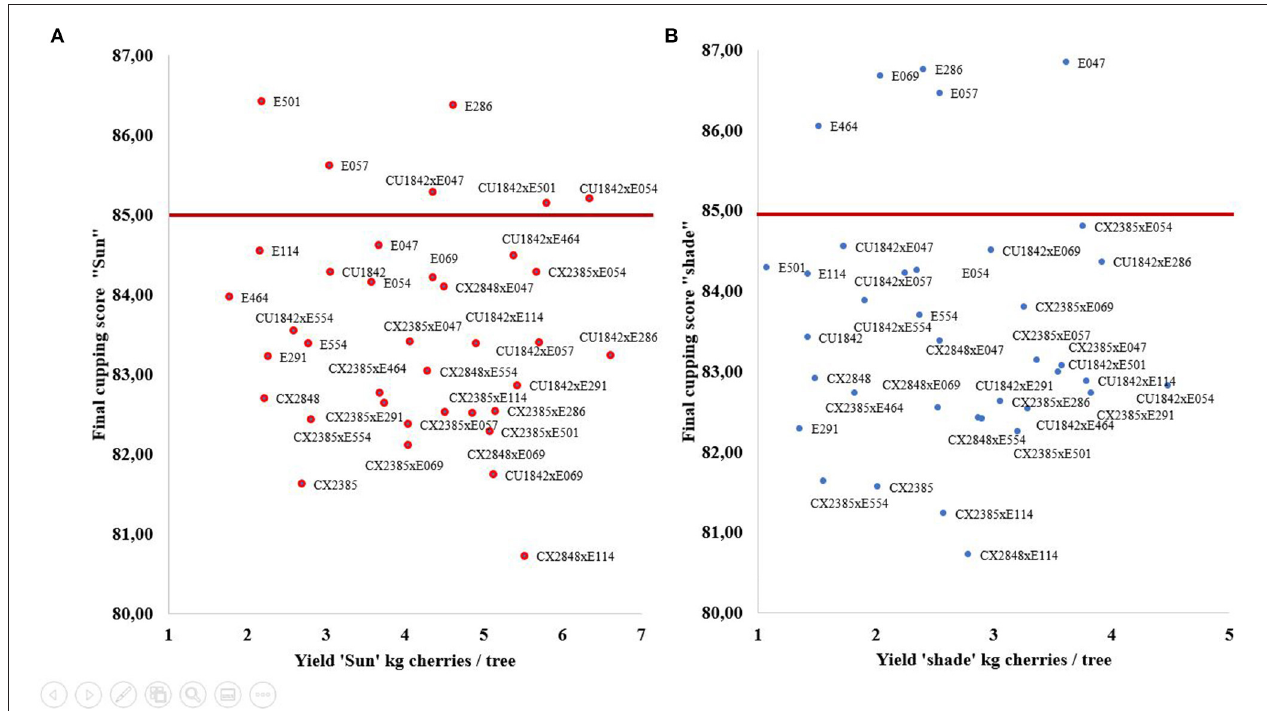
FIGURE 3 | Selection for “specialty coffee.” Scatterplots showing the final cupping score and yield. The genotypes inside the rectangle were selected because they produced higher performances than the threshold (blue line) in terms of the final cupping score. (A) selection in the full-sun trial; (B) in the “shade” trial.